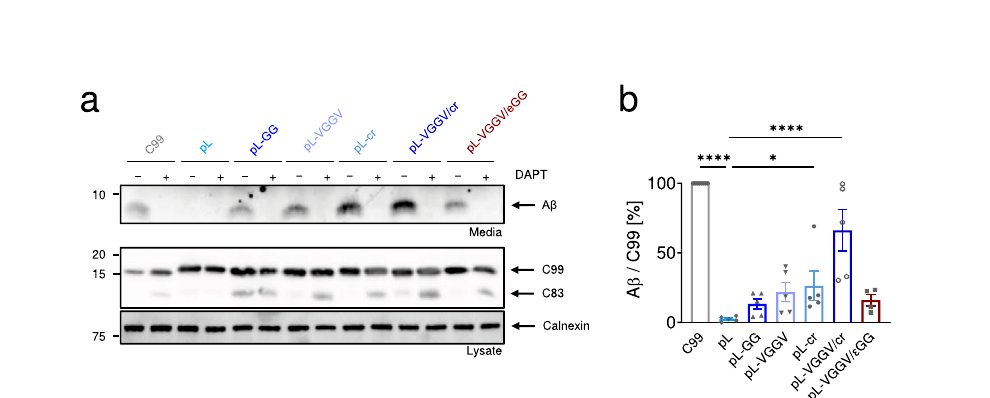
Fig. 6 In fl uence of TMD sequence on A β production recapitulated in cellulo. HEK293 cells were transiently transfected with the indicated wt and pL-